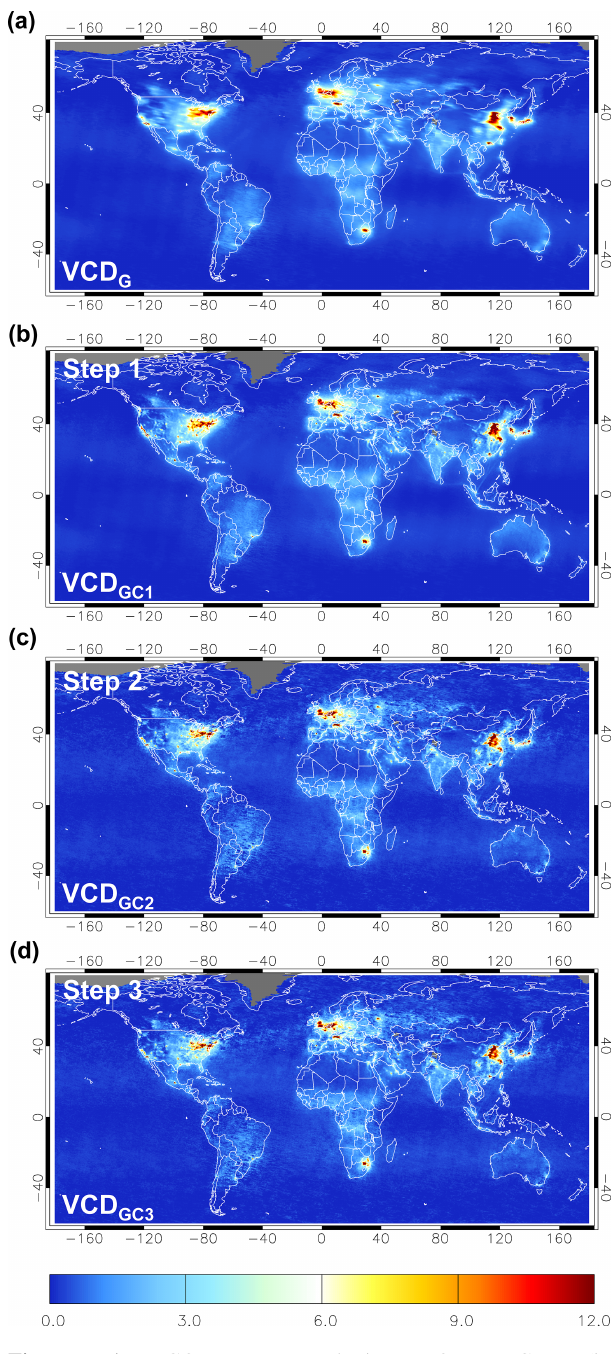
Figure 1. GOME tropospheric NO 2 VCD (in 10 15 moleculescm − 2 ) patterns for the whole GOME period from the original VCD G data (a) , from the VCD GC1 data corrected in step 1 (b) , from the VCD GC2 data corrected in step 2 (c) , and from the VCD GC3 corrected in step 3 data (d)